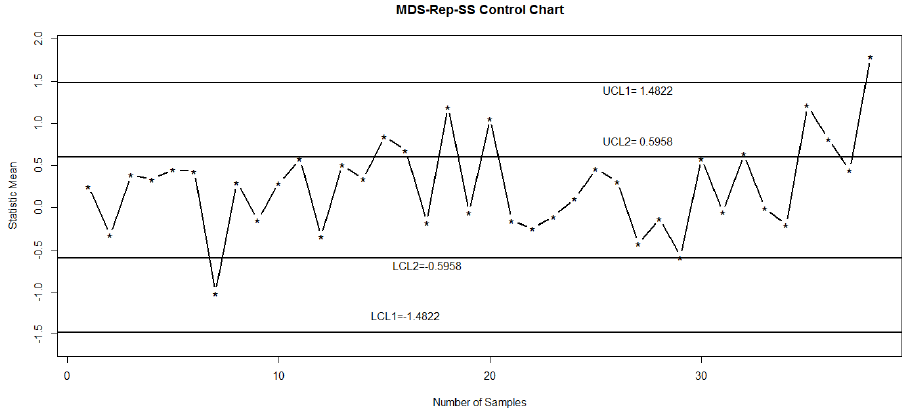
Figure 3. Proposed control chart for simulation data: ARL 0 = 370 for 𝑖 = 2 and 𝜌 = 0.6 with 𝑛 = 30 .